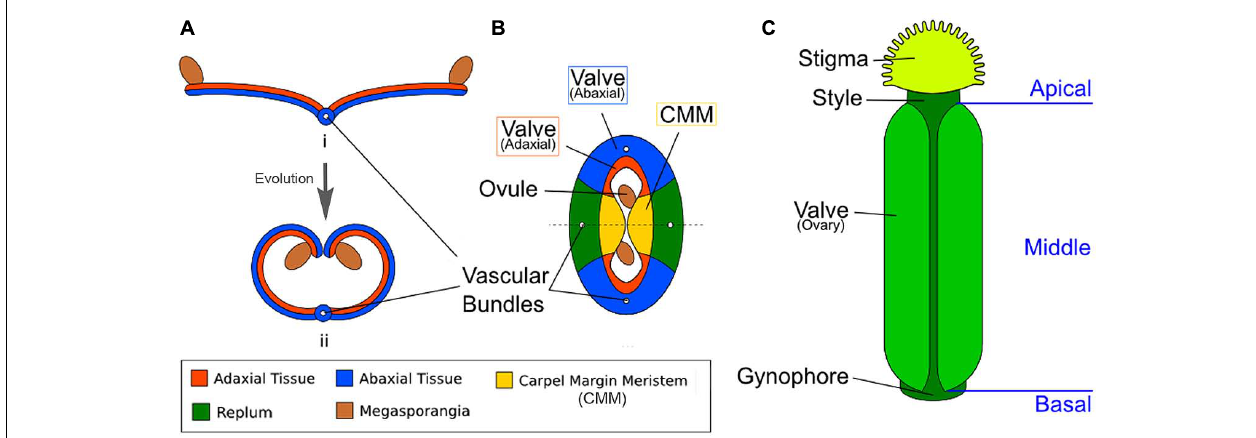
FIGURE 1 | Diagrams illustrating the homology between modern carpels and ancestral leaves. (A) Hypothetical evolution of a single plicate carpel based on Scagel (1965). (i) A cross section of an ancestral plant’s spore-bearing leaf (sporophyll), showing megasporangia at the leaf edge. (ii) Over evolutionary time, inward curling of a megasporangia-bearing leaf and subsequent fusion at the leaf margin led to a one-chamber ovary with two rows of megasporangia on the interior (adaxial side). The actual evolutionary path is more complicated and not fully settled. (B) The cross